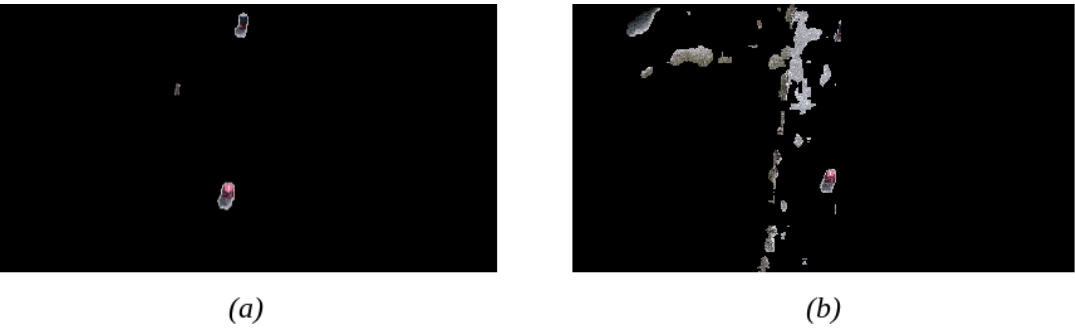
Figure 10. Effect of the image alignment component on the system’s output. ( a ) The resultant image with the image alignment applied, while ( b ) represent the results obtained without the use of the component. As can be observed, the aligned image detects changed elements (in this case, the two red boxes) more